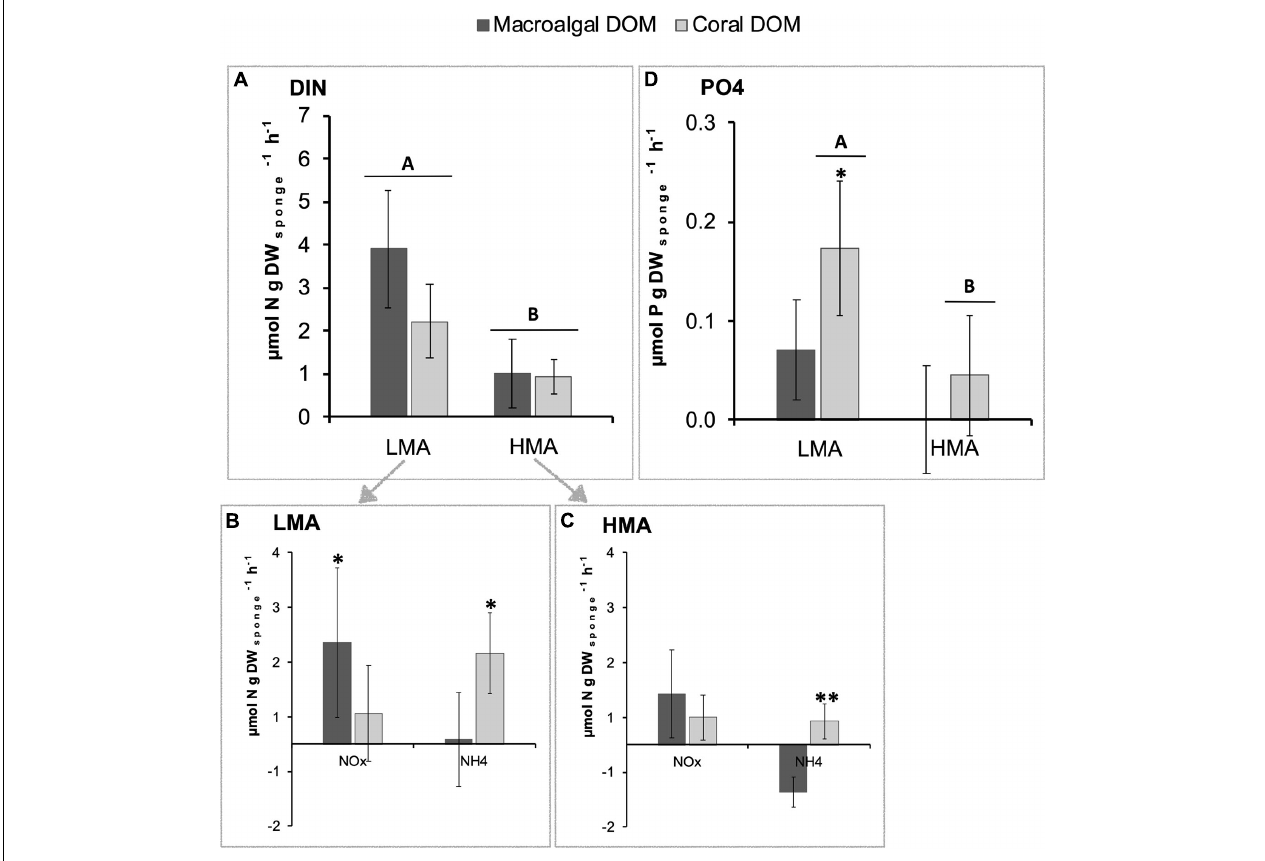
FIGURE 5 | Average net inorganic nutrient fluxes of sponges fed with naturally sourced macroalgal- and coral-DOM. Positive values indicate net release and negative values indicate net uptake. In dark gray macroalgal-DOM and in light gray coral-DOM. Shown are (A) dissolved inorganic nitrogen (DIN) fluxes of LMA sponges and HMA sponges, (B) NO x and NH 4 fluxes of LMA sponges, (C) NO x and NH 4 fluxes of HMA sponges, (D) PO 4 fluxes of LMA sponges and HMA sponges. Data presented as mean rate in µ mol N or P g DW sponge h − 1 ) ± 95%-CI ( n = 10 ). Letters (A and B) indicate significant differences between LMA and HMA sponges and asterisks ( ∗ ) indicate significant differences between the sources per sponge type (LMA/HMA). Signif. codes: ∗∗ p < 0.01, ∗ p <